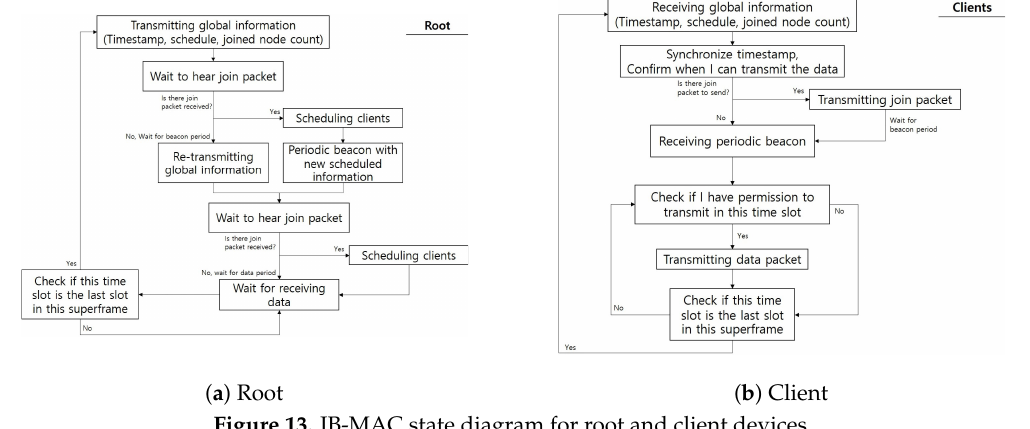
Figure 13. IB-MAC state diagram for root and client